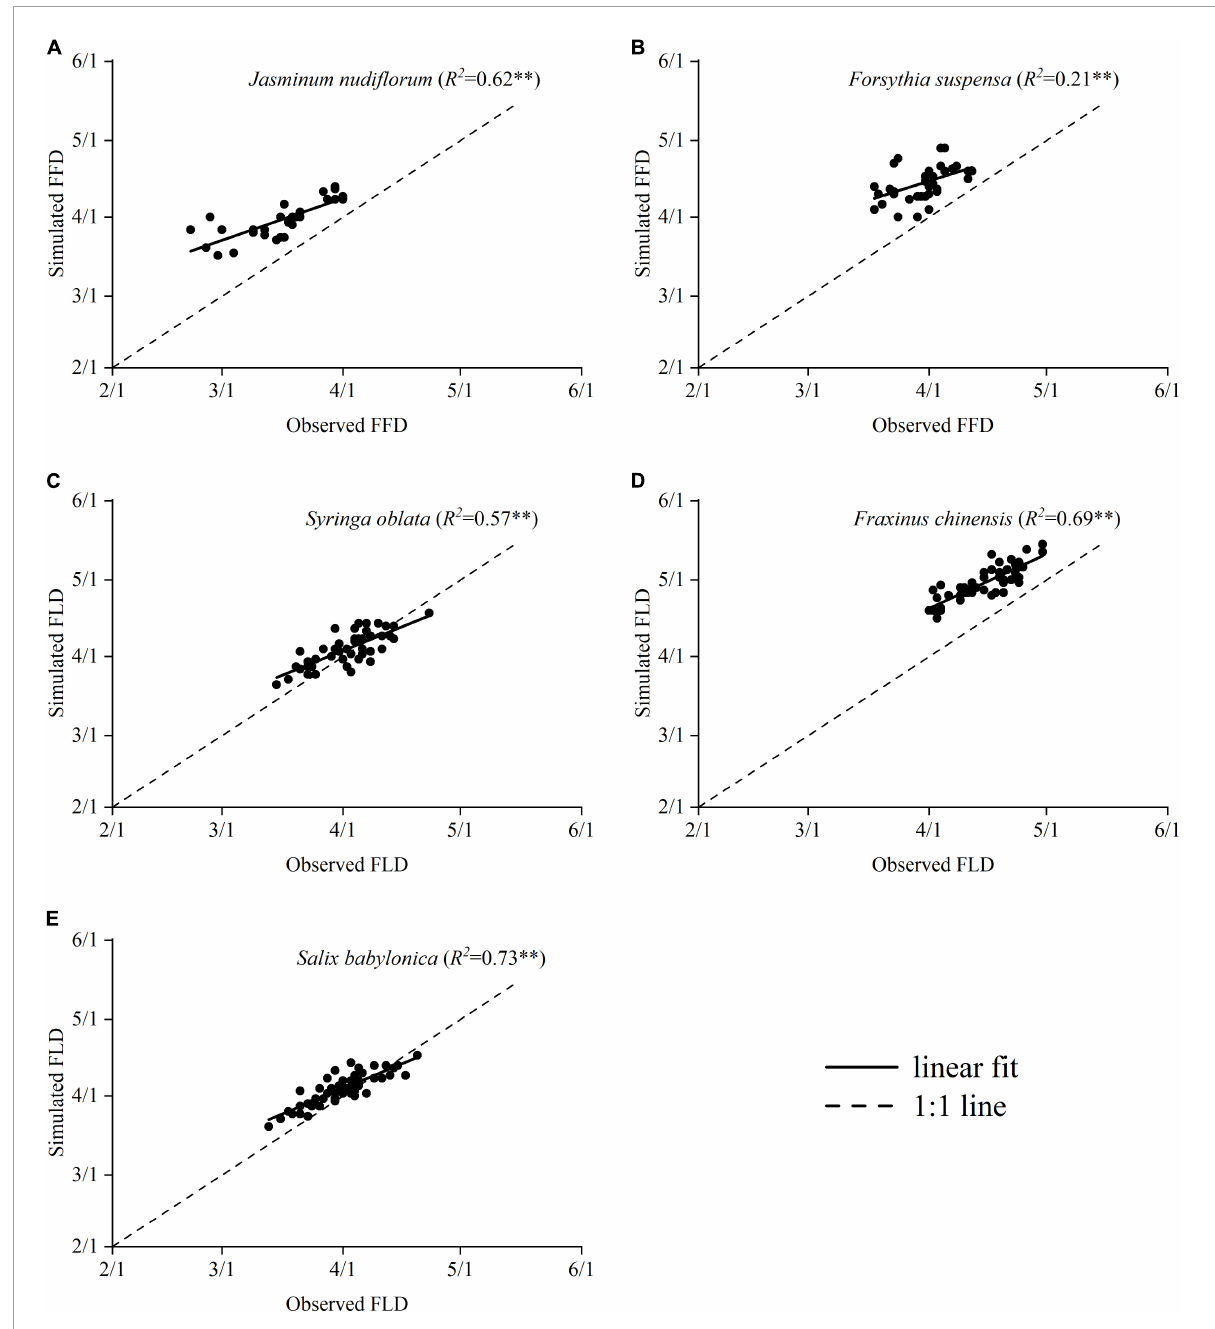
FIGURE8 Relationships between simulated spring events and observed spring events. FLD, the first leaf date; FFD, first flowering date. The black dotted line represents when the observed and simulated values are equal. ∗∗ p < 0.01. (A) J. nudiflorum , (B) F. suspensa , (C) S. oblata , (D) F. chinensis , and (E) S. babylonica